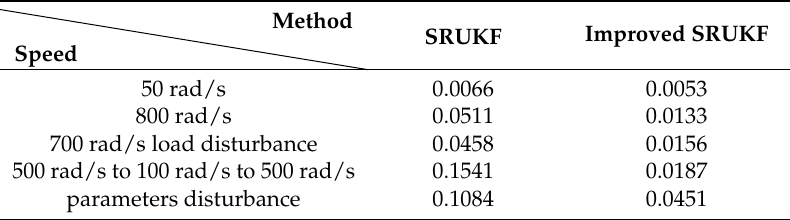
Table 3. RMSE of space position